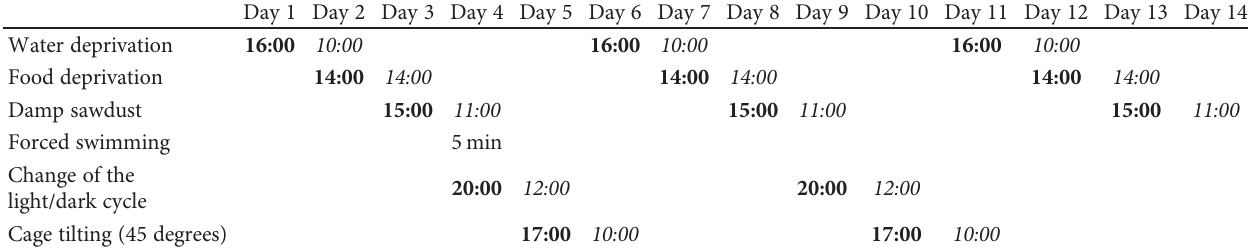
Table 1: Unpredictable chronic mild stress (UCMS). The text in bold denotes the start time of the respective types of mild stress exposure; the italicized text denotes the end of the